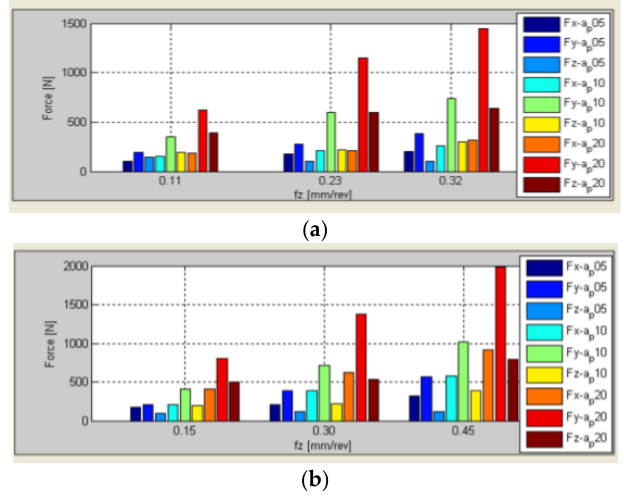
Figure 8. Cutting forces from Dynpro ® for two turning inserts: ( a ) Rhombic 35° (VBMT); ( b ) Square 45° (SNMG).